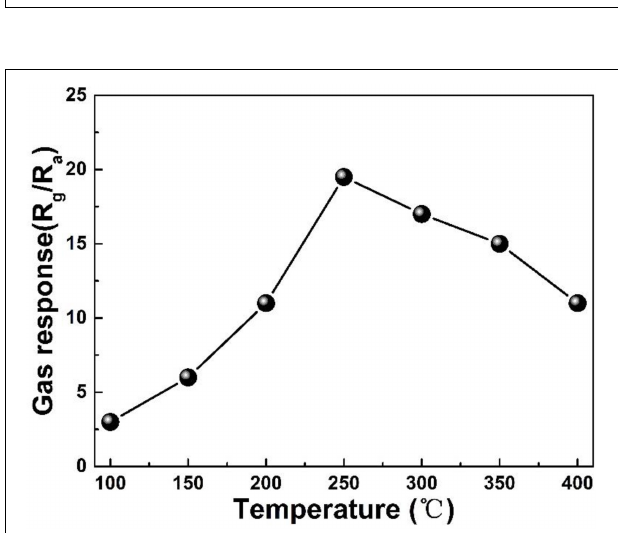
FIGURE 5 | Typical nitrogen adsorption-desorption isotherms and BJH pore size distribution analysis.